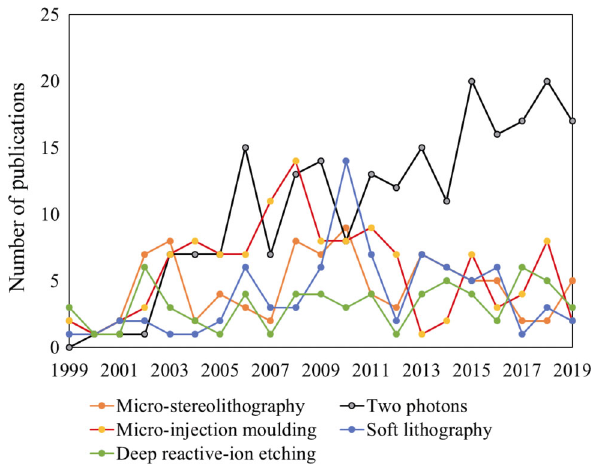
Number of published papers using micro- stereolithography, two photons, micro injection moulding, deep reactive ion etching, soft lithography over the last 20